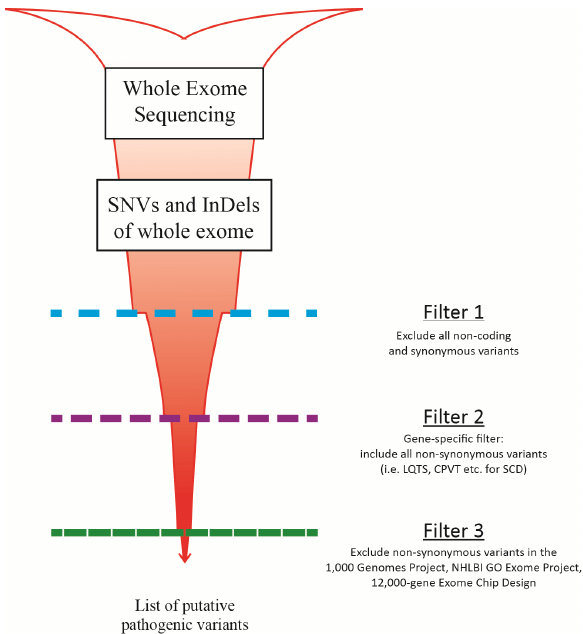
Figure 6. General overview of the three different filters used for the whole exome sequencing approach for sudden cardiac death variant